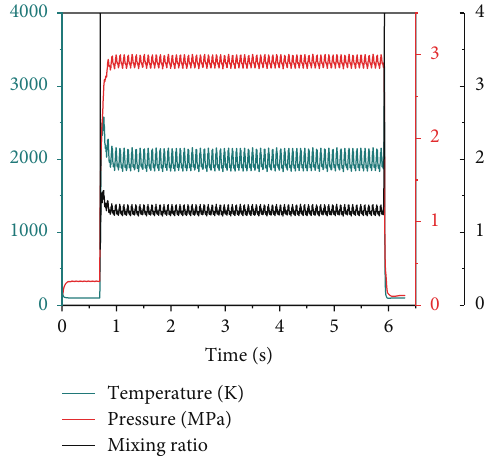
Figure 9: Thermal conditions of the combustion chamber.